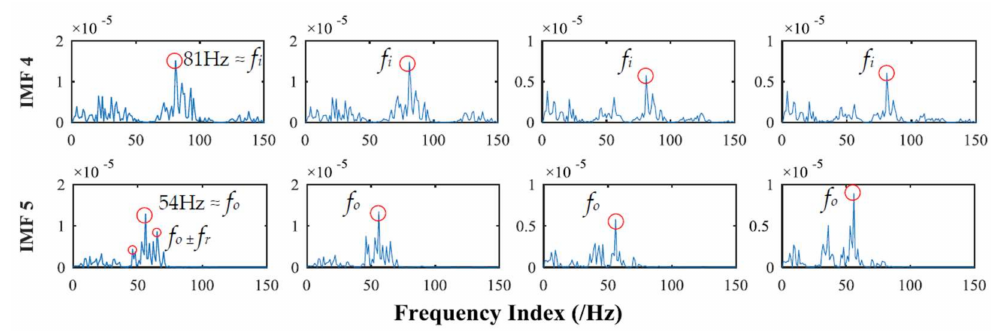
Figure 21. Frequency domain plots of effective IMFs of